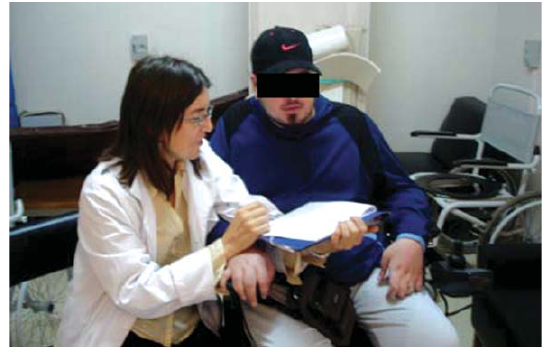
Fig. 7. Occupational therapist gathering user’s